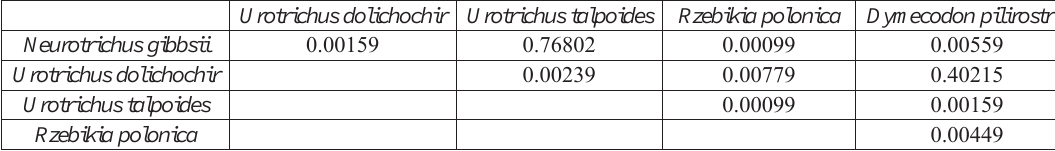
Table 2. Pairwise permuted ANOVA results. All p-values are corrected using “Holm” correction. Urotrichus dolichochir Urotrichus talpoides